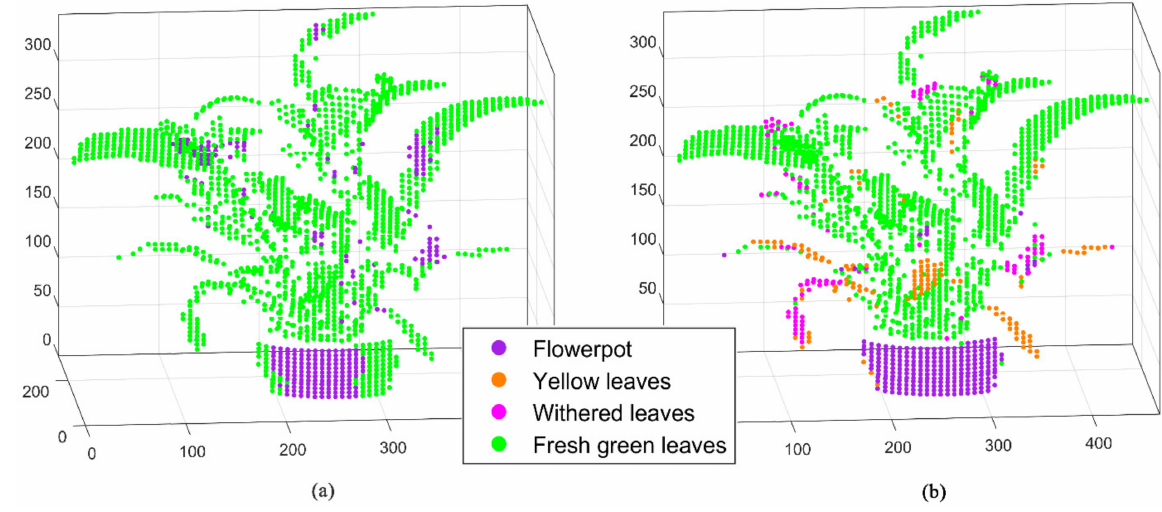
Figure 10. Normal vectors and normal vectors with four-channel spectral classification results (Scene 2): ( a ) Normal vectors data and ( b ) Normal vectors with four-channel spectral data for classification. Table 3. Confusion matrices of the normal vectors and normal vectors with four-channel spectral classification results for Scene 2 (corresponding to Figure